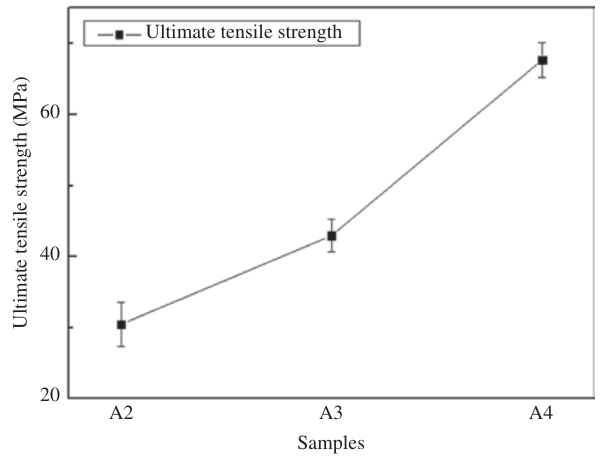
Figure 8: Ultimate tensile strength of samples.